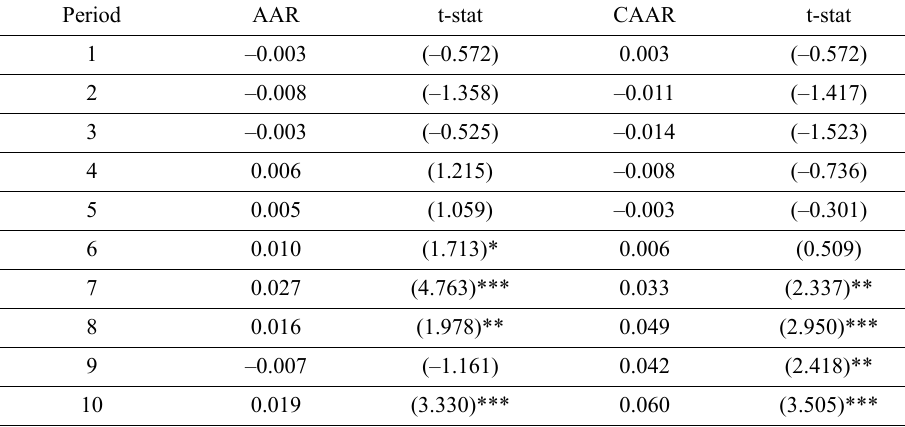
Table 1. Announcement window monthly abnormal returns of all